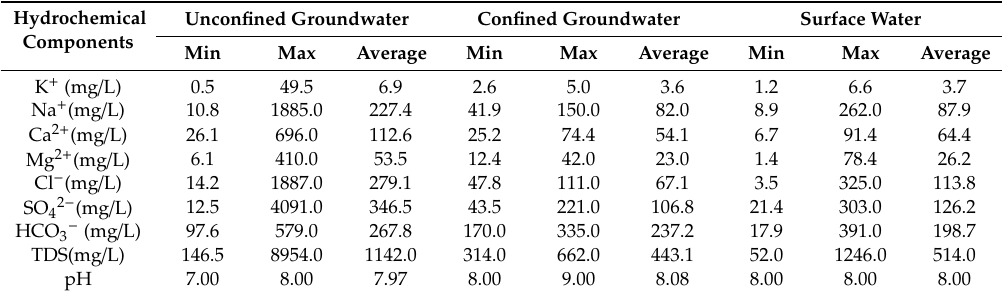
Table 1. Summary of descriptive statistics of di ff erent hydrochemical parameters of all the 123 samples (including 6 surface water samples, 12 confined groundwater samples, and 105 unconfined groundwater